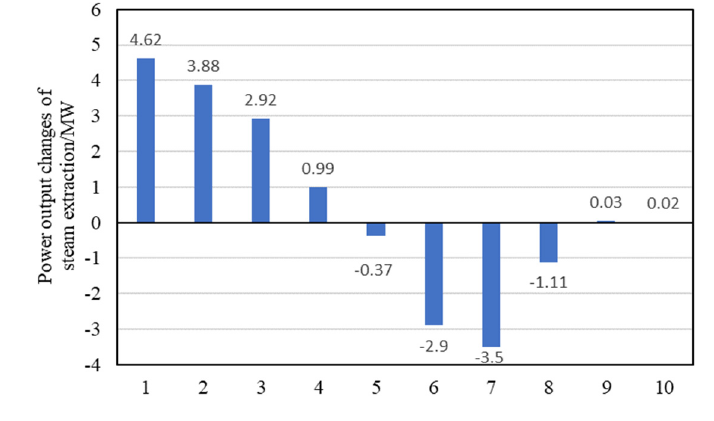
Figure 15. Variation of steam extraction at different levels.